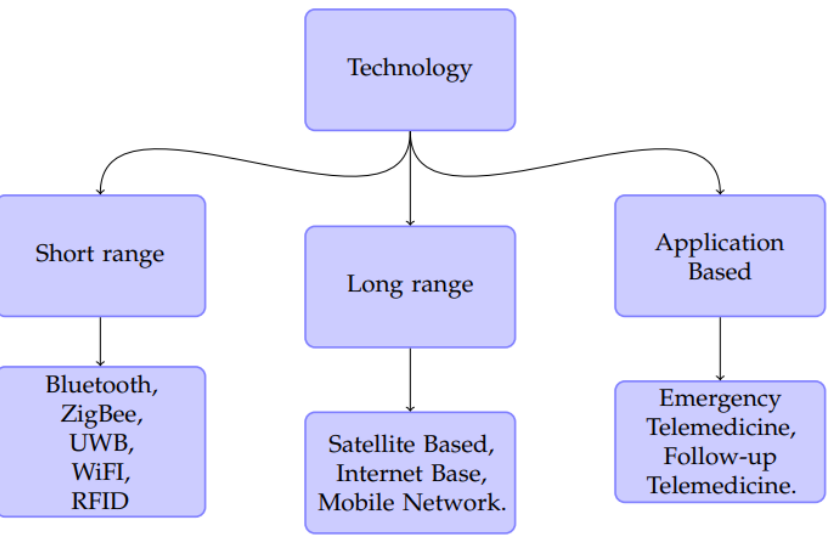
Figure 10. Classification of Communications Technologies used in